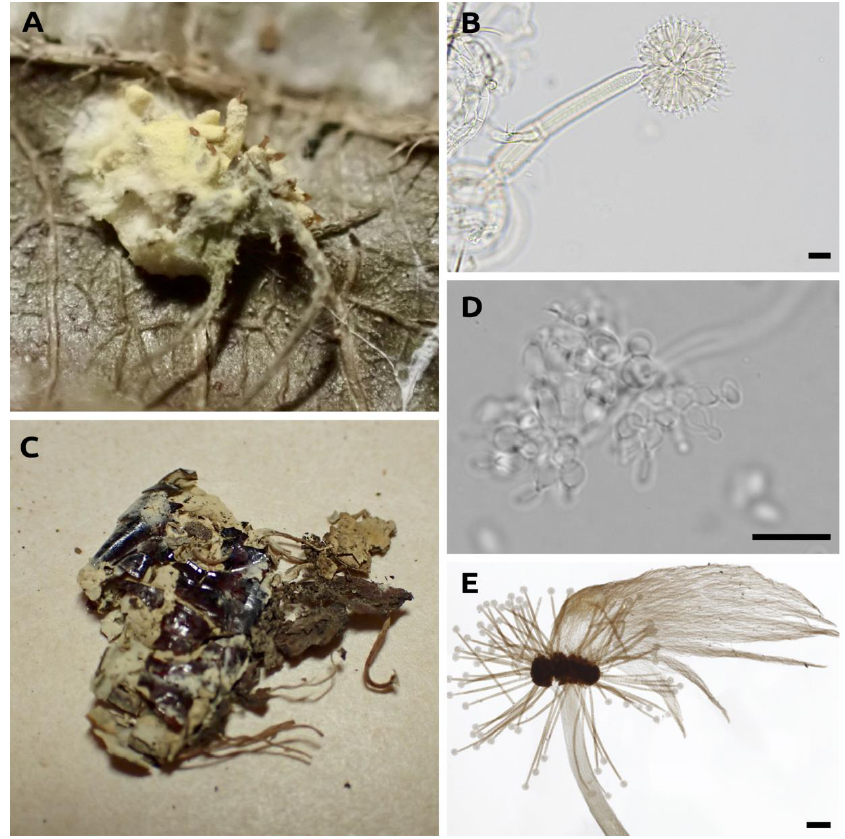
Figure 6. Type specimens of Gibellula alata , Gibellula eximia , and T. gibellulae (synonymized to G. pulchra ). ( A ) Specimen of T. gibellulae (= G. pulchra ); ( B ) conidiophore of T. gibellulae aspergillate, the most common shape for the genus; ( C ) Specimen of G. eximia ; ( D ) conidiophore of G. eximia with different shape of conidiogenic cells; and ( E ) wing-like synnema of G. alata bearing aspergillate conidiophores. Microscopic structures were photographed in light microscopy. Scales: ( B , D ): 10 µ m; ( E ) 200 µ